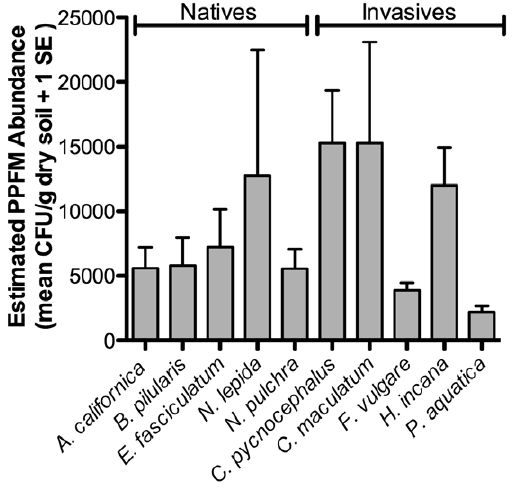
Figure 1. Average PPFM abundance for each species (pure and mixed stands pooled). Two-way ANOVA, Factor: species (F 1,9 =3.15, P=0.0034, N=82). Species with the same letters are not significantly different from each other (Tukey post hoc test a =0.05, Q=3.64). Error bars were constructed with one standard error of the mean for all soil samples taken under each plant species.